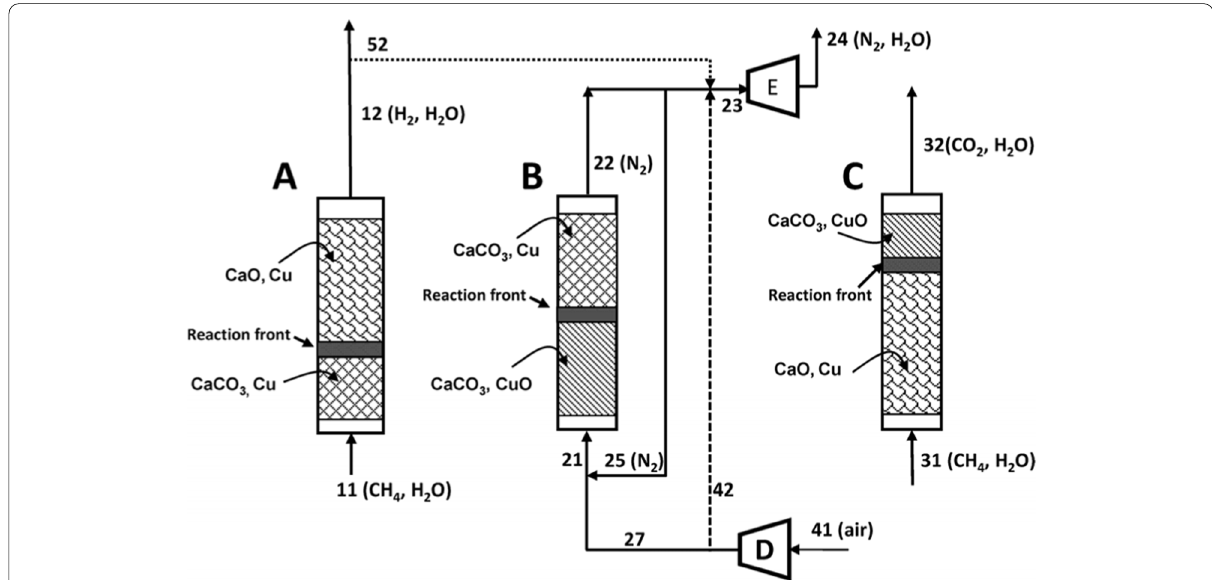
Fig. 19 A possible integration of the calcium-looping with SMR for power generation employing natural gas as energy source